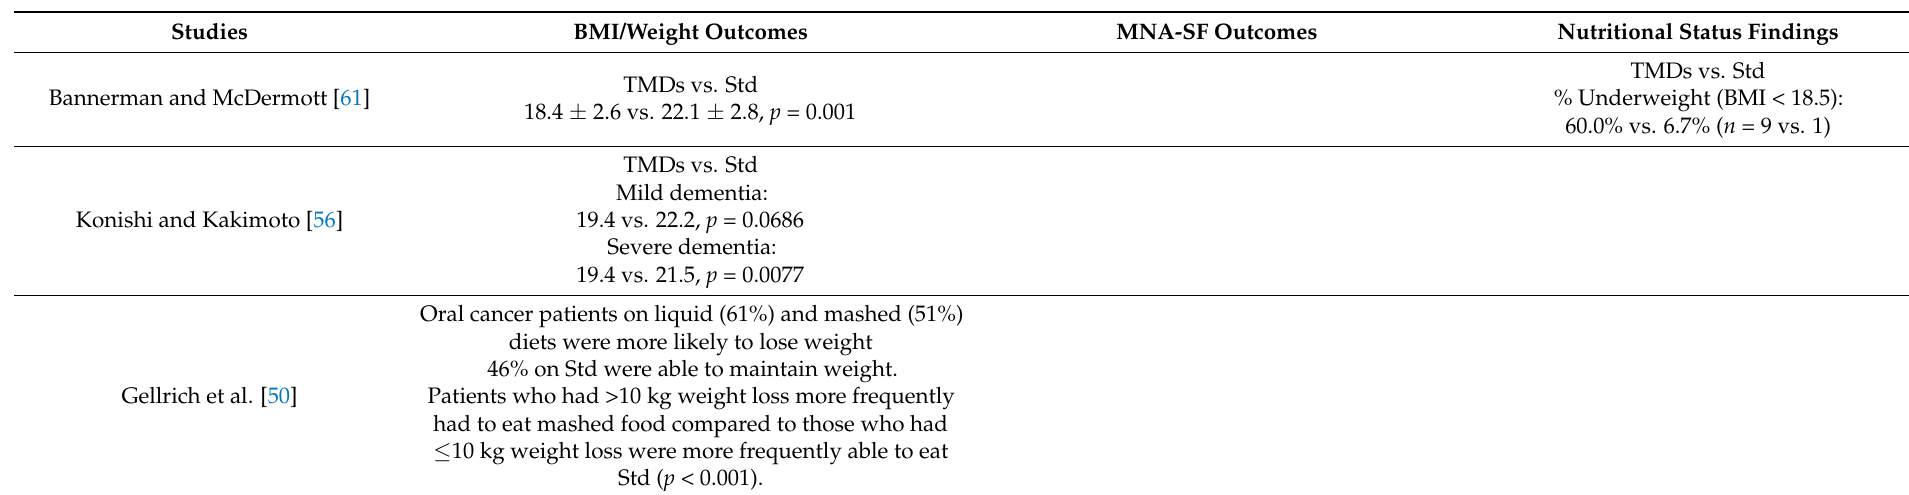
Table 2. Outcome data for observational studies assessing nutritional